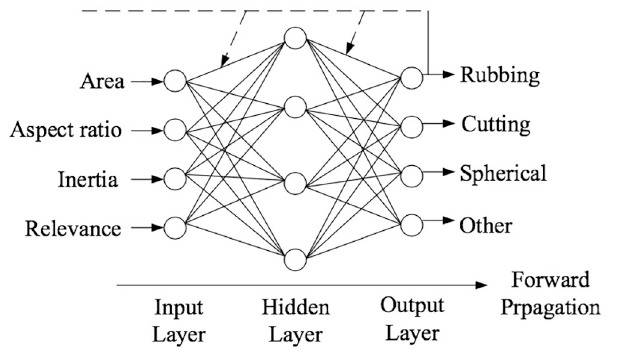
Fig 1. Schematic diagram of the BPNN